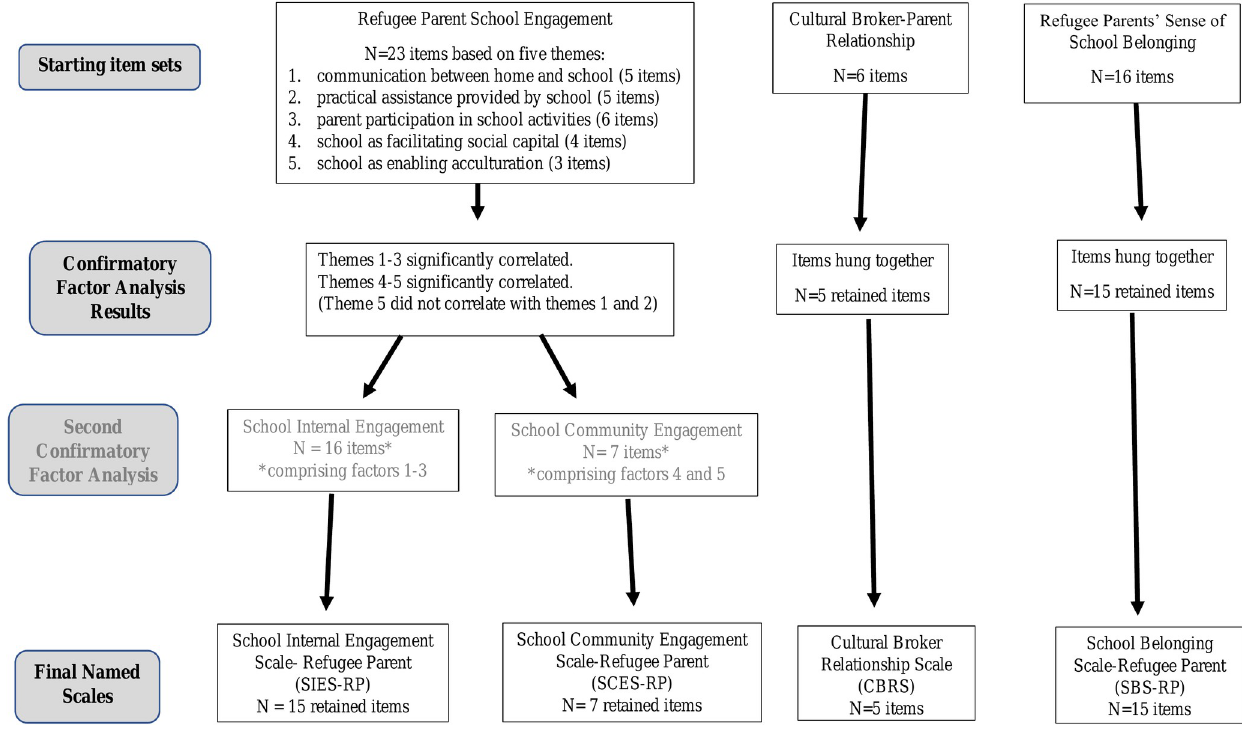
Fig 2. The process of measure